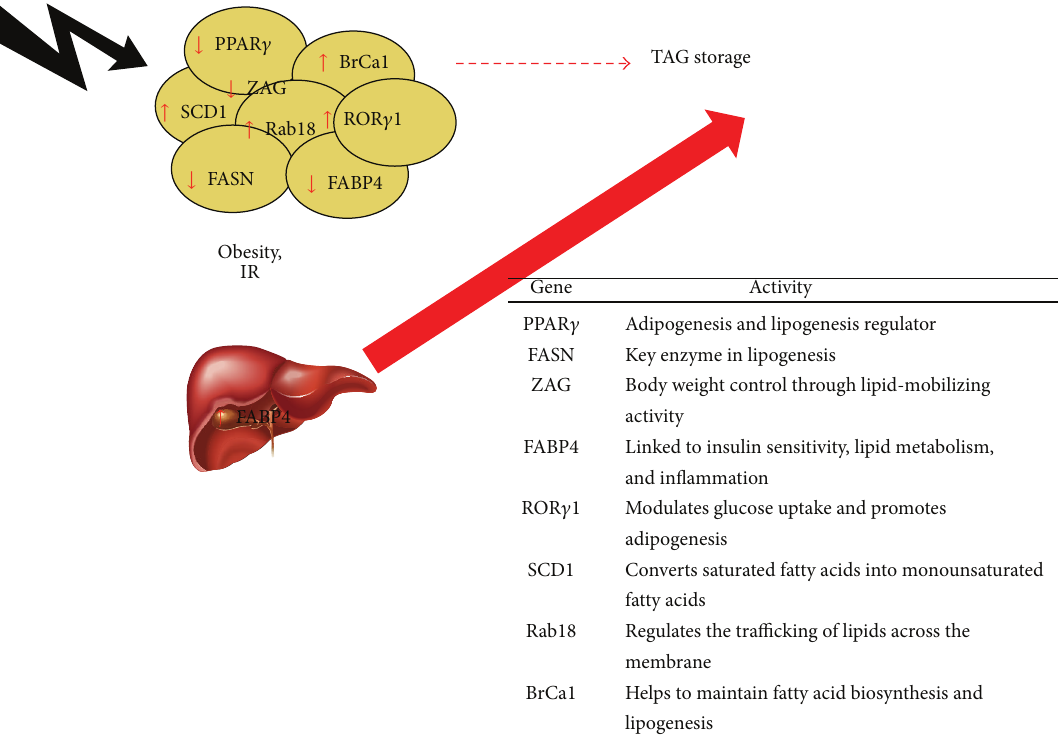
Figure 1: Lipogenic pathway in obese patients. The loss of the lipogenic capacity of the adipose tissue is compensated by other tissues and organs, mainly the liver. Thus, many molecules come into play in this loss of lipogenic capacity of the adipose tissue, acting in a wrong way. HFD: high fat diet; IR: insulin resistance; TAG: triacylglycerol; PPAR 𝛾 : peroxisome proliferator-activated receptor- 𝛾 ; FASN: fatty acid synthase; ZAG: zinc- 𝛼 2 glycoprotein; FABP4: fatty acid-binding protein 4; ROR 𝛾 1: retinoic acid receptor-related orphan nuclear receptor 𝛾 1; SCD1: stearoyl-CoA desaturase-1; Rab18 : Ras-related protein 18 ; BrCa1: breast cancer